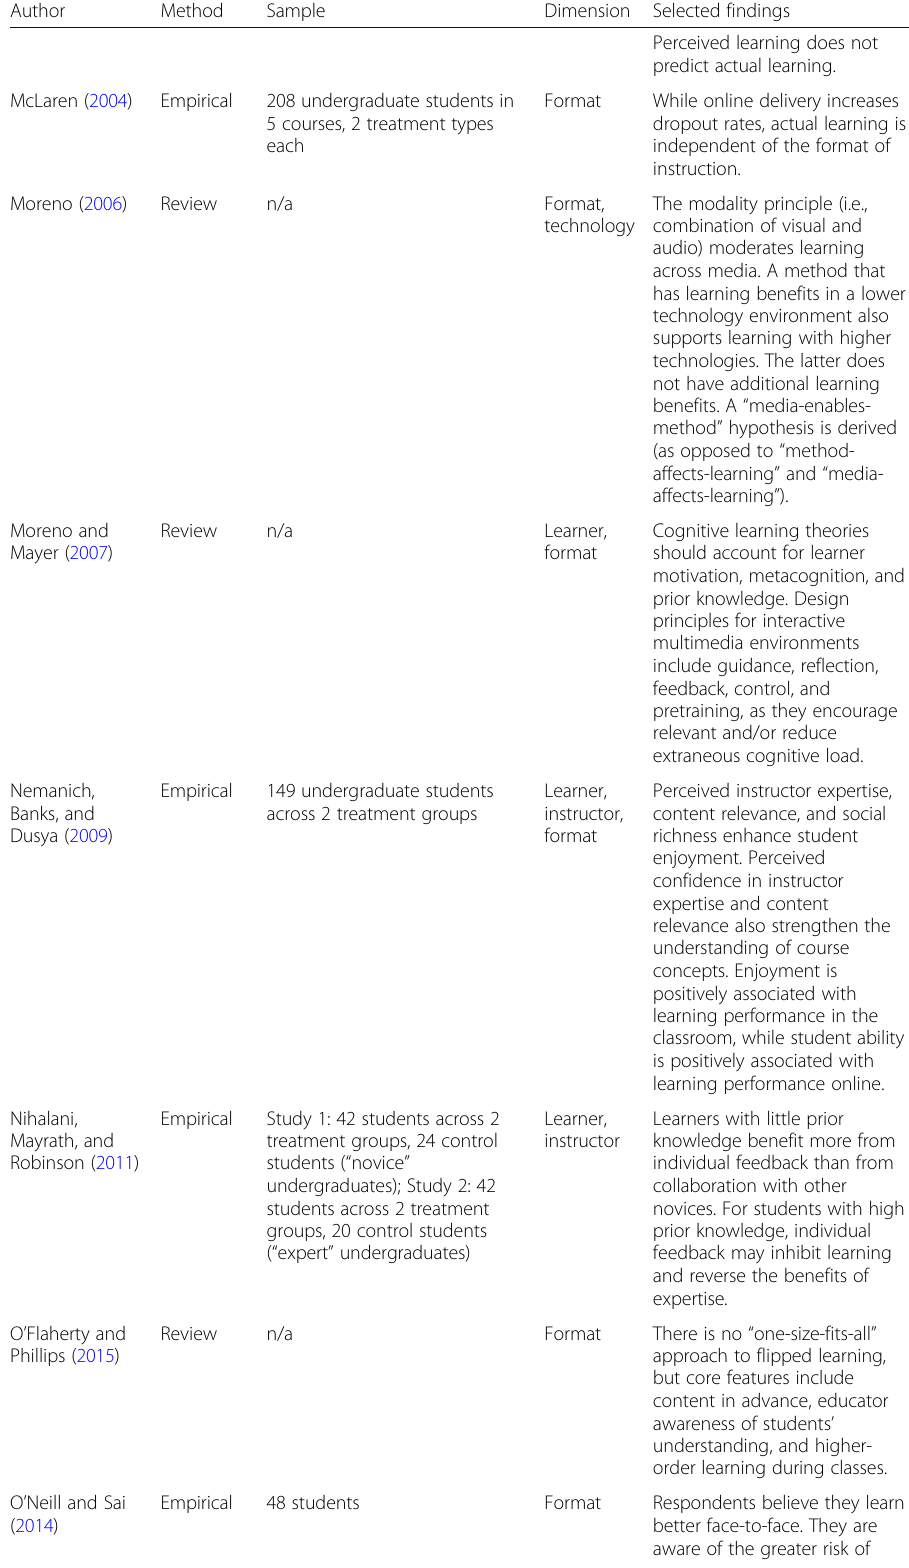
Table 1 Overview of Findings from the Extant Literature